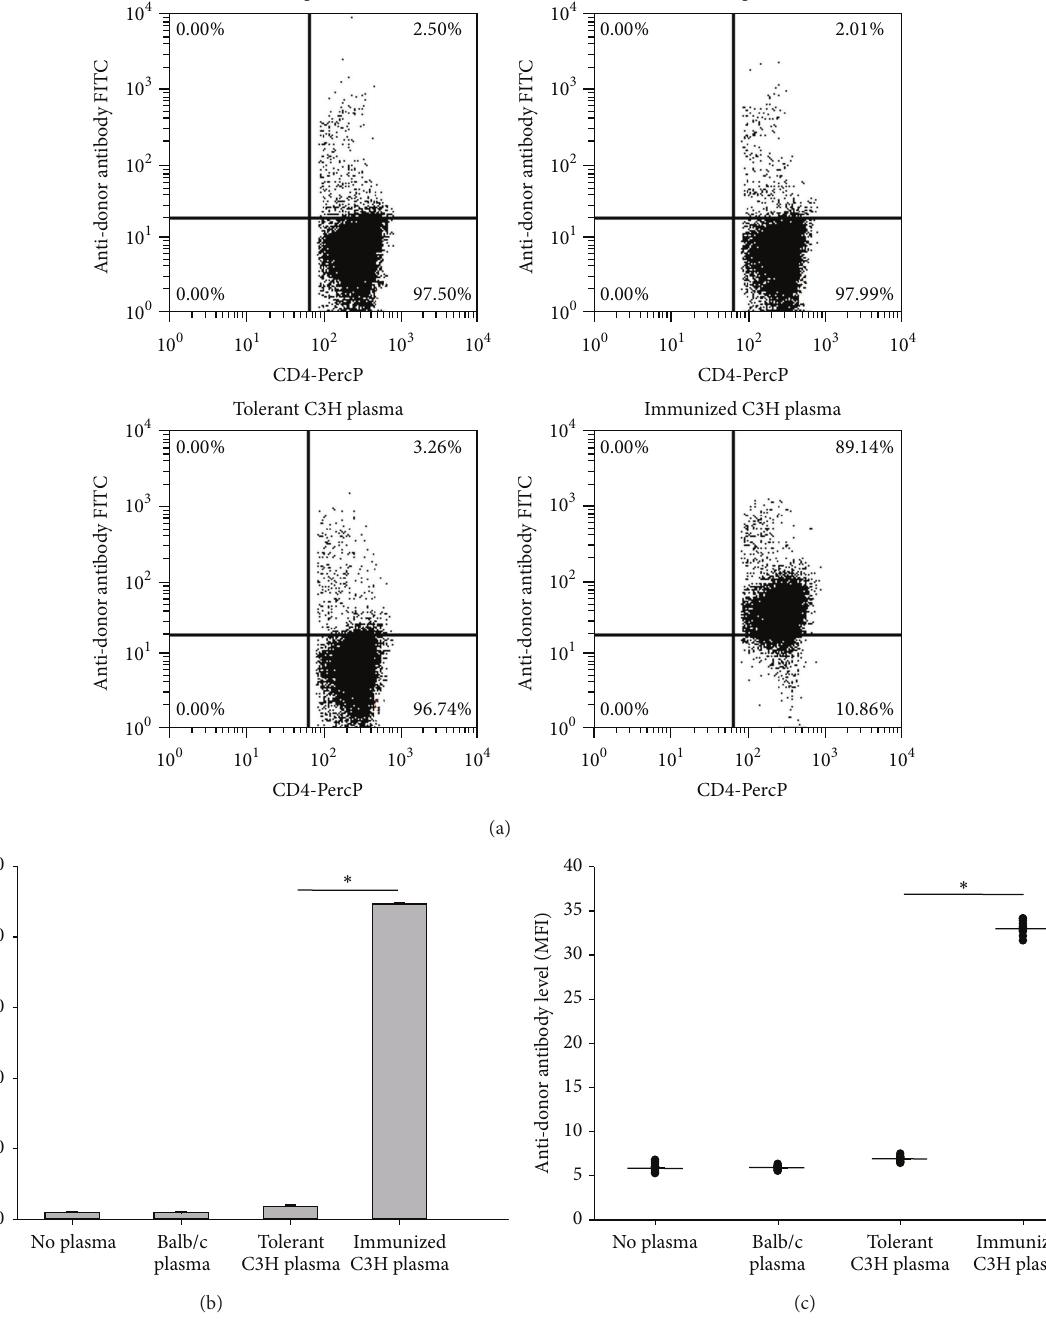
Figure 1: Alloantigen-specific tolerance induced by infusion of UVB-iDCs can be maintained for long term. (a) Recipient C3H mice (H2k) were treated with 4 weekly intravenous injections of donor Balb/c (H2d) UVB-iDCs or PBS (10 mice/group). Six weeks later, all mice were challenged by infusion of Balb/c spleen cells (2 × 10 5 /mouse) once a week for two weeks. One week after the second challenge, plasma levels of anti-donor antibodies were examined. Na¨ıve Balb/c mouse plasma samples were utilized for testing the background binding. Balb/c spleen cells with plasma added were blank controls. ((b) and (c)) The summary of anti-donor antibodies levels in both percentage and mean fluorescent intensity (MFI) is depicted, respectively. Data represent mean ± standard error. ∗ 𝑃 < 0.05 . The 𝑃 values were calculated using Student’s 𝑡